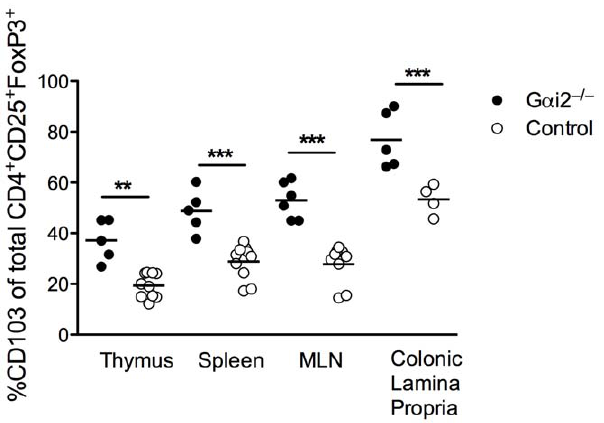
Figure 3. Expression of integrin a E (CD103) on CD4 + CD25 + FoxP3 + Treg cells from central, peripheral and mucosal lymphoid tissue. Frequencies of CD4 + CD25 + FoxP3 + Treg cells in thymus, spleen, mesenteric lymph nodes (MLN) and colon from 5 to 8 weeks old colitic G a i2 2 / 2 mice and age-matched WT littermates. (n $ 6 in each group), expressing CD103 were determined by FACS analysis. Gates were set on the CD4 + CD25 + FoxP3 + subpopulation of lymphocytes. Each symbol represents one mouse and the mean is indicated by a line. Results pooled from at least three independent experiments, where **=p # 0.01 and ***=p # 0.001.